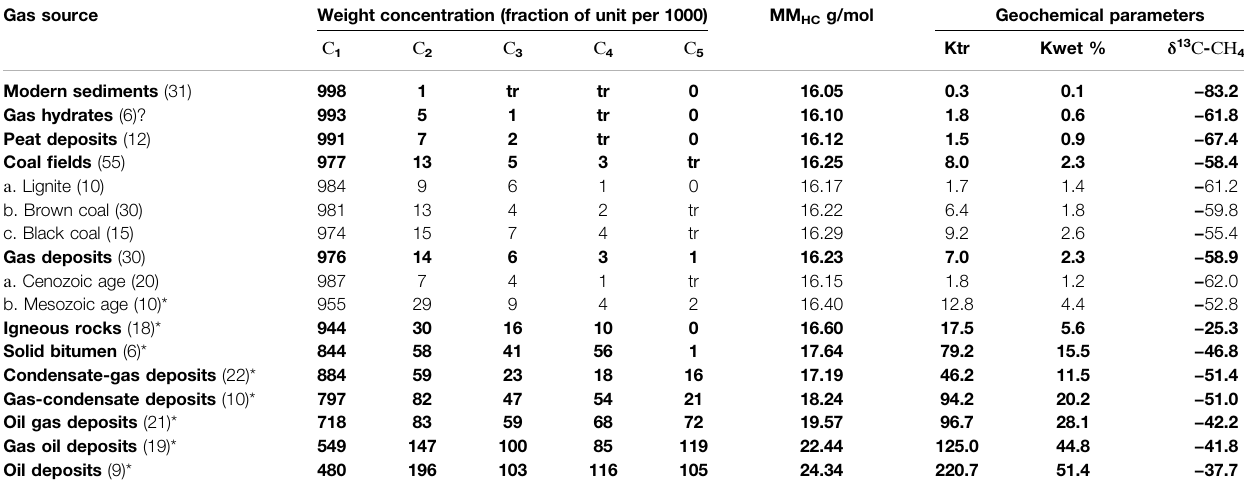
TABLE 3 | Average values of geochemical indicators of bottom sediment hydrocarbon gases of the inner shelf of the East Siberian